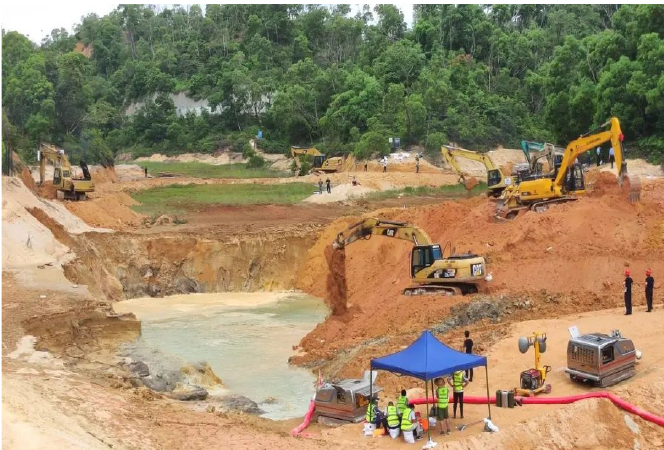
Figure 4. Rescue site cofferdam construction (Picture from: https://www.guancha.cn/poli-